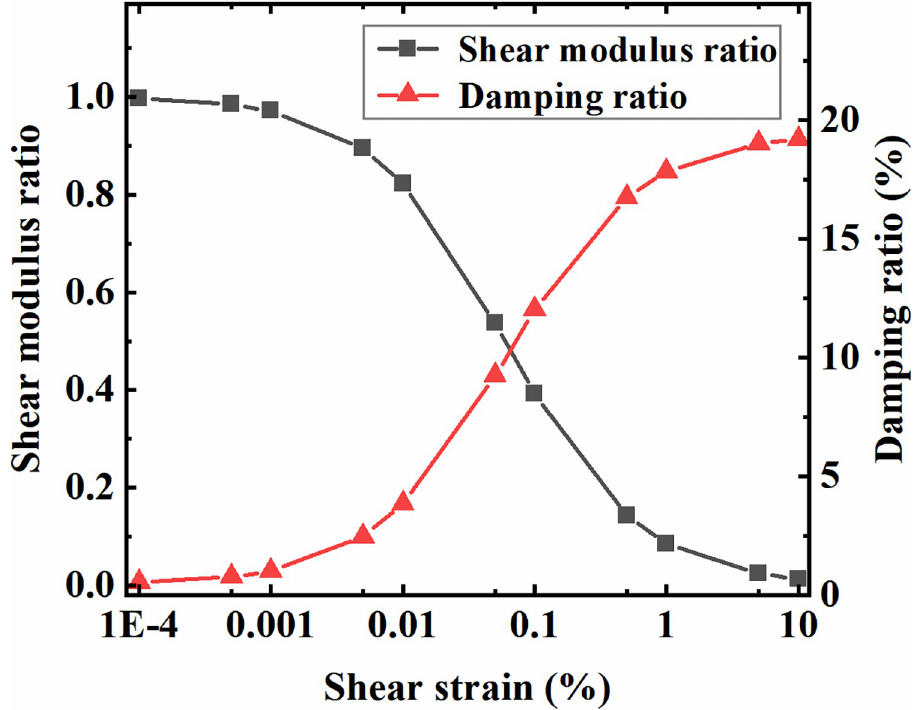
Fig 2. Dynamic shear modulus ratio and damping ratio with the dynamic shear strain of the soil.